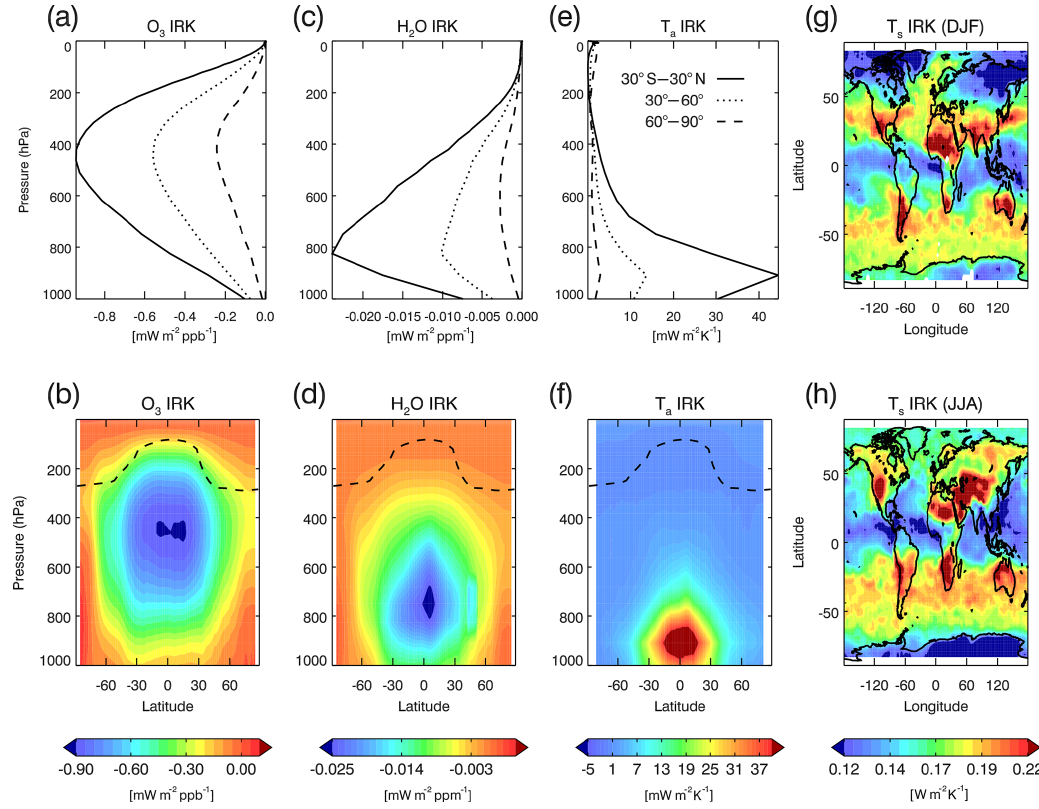
Figure 2. TES 2006 IRK for four primary components (O 3 , H 2 O, T a , and T s ). Panels (a) , (c) , and (e) are IRKs of latitudinal band averages in the tropics (30 ◦ S–30 ◦ N), midlatitudes of both hemispheres (30–60 ◦ ), and high latitudes of both hemispheres (60–90 ◦ ). The figures below them are the pole-to-pole vertical distribution of the zonally averaged IRK. The global distribution of IRK for T s is plotted for winter season (December to February) (g) and summer season (June to August) (h)